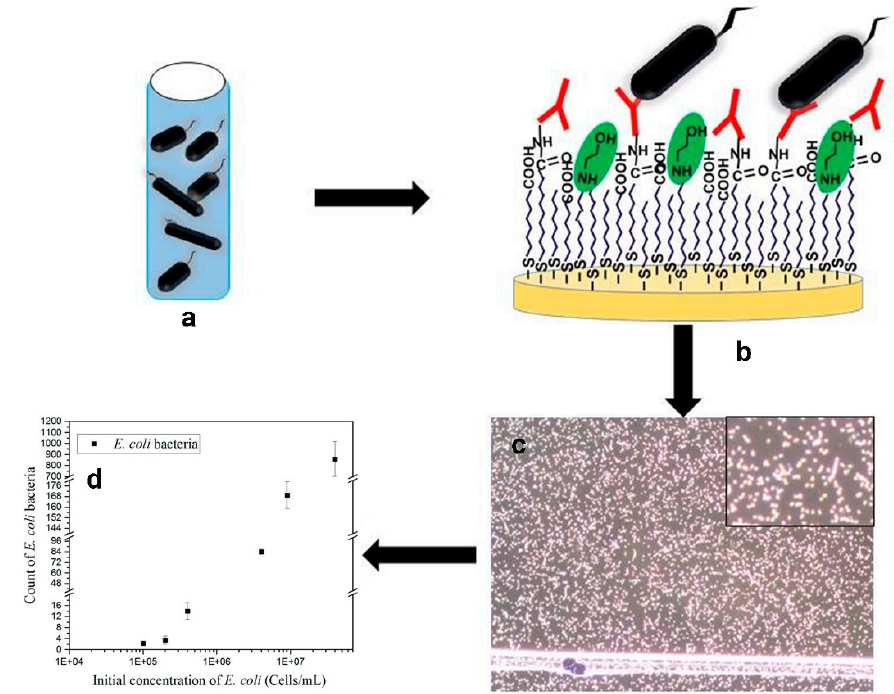
Figure 6. Schematic of detection of E. coli with dark-field microscopy. ( a ) Samples containing E. coli. (b) an anti- E. coli antibody functionalized gold surface. ( c ) Dark-field microscopy is used to inspect the surface of the gold sheet after 75 min incubation with the field sample and rinse with phosphate buffer solution, enlarging the image. ( d ) Statistical image analysis was used to count the bacteria captured by the antibodies [40]. Adapted with permission from Ref. [40]. Copyright © 2019